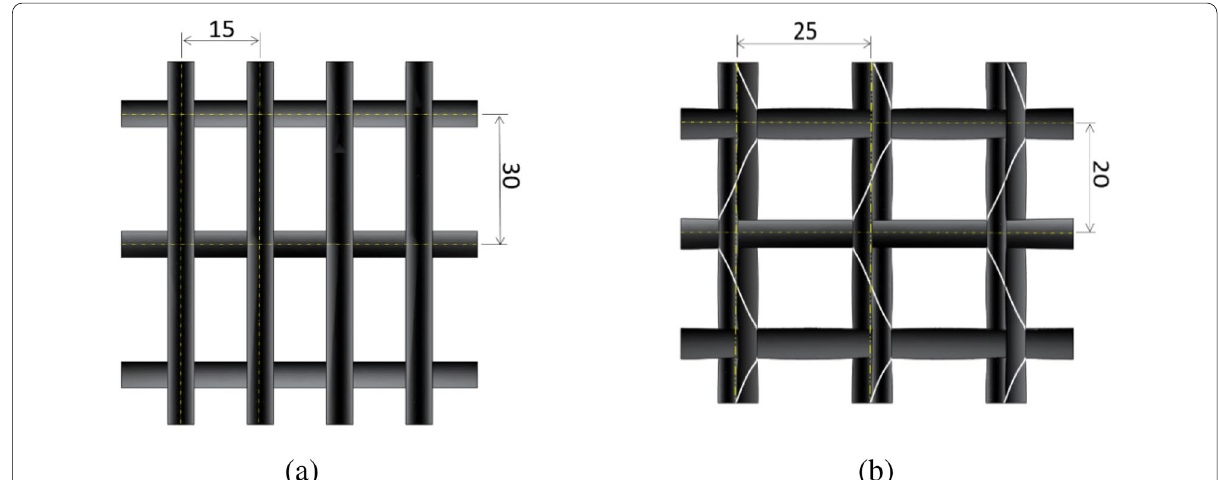
Fig. 2 Carbon fabrics made of CF 12K rovings: a laboratory-made bonded fabric used for tensile test and lap-splice test; b commercial woven fabric used for column confinement test.